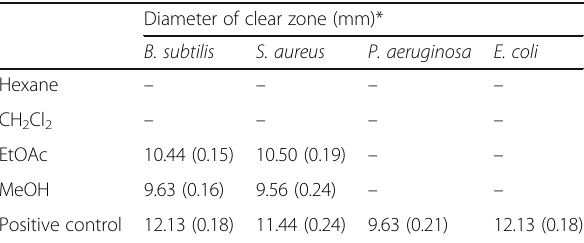
Table 3 Mean diameters of clear zones developed with different extracts of F. racemosa with Bacillus subtilis, Staphylococcus aureus, Pseudomonas aeruginosa and Escherichia coli